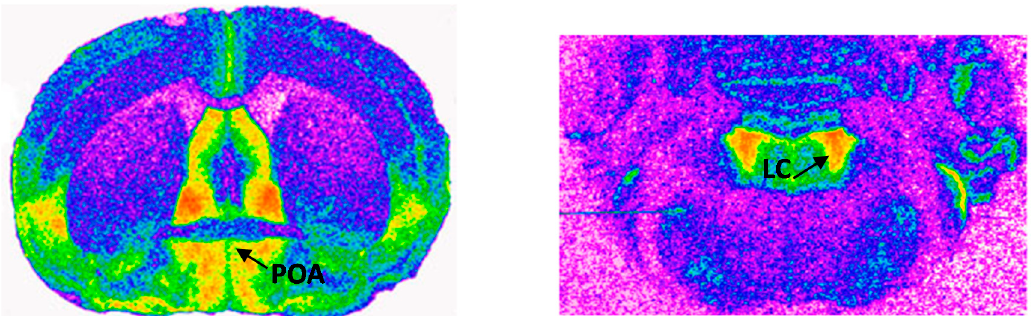
Figure 3. Effects of prenatal exposure to BPA on alpha 2 adrenergic receptor affinity in the locus coeruleus and preoptic area. Binding curves for preoptic area of control ( a ) and BPA ( b ) groups. ( c ) Affinity (Kd) in the locus coeruleus; ( d ) affinity in the preoptic area. (OIL: eight males and eight females; BPA: eight males and seven females). Dark columns = males. * p < 0.05 OIL females vs. BPA females; # p < 0.05 BPA vs. OIL. Data are presented as mean ±SE. POA = preoptic area.